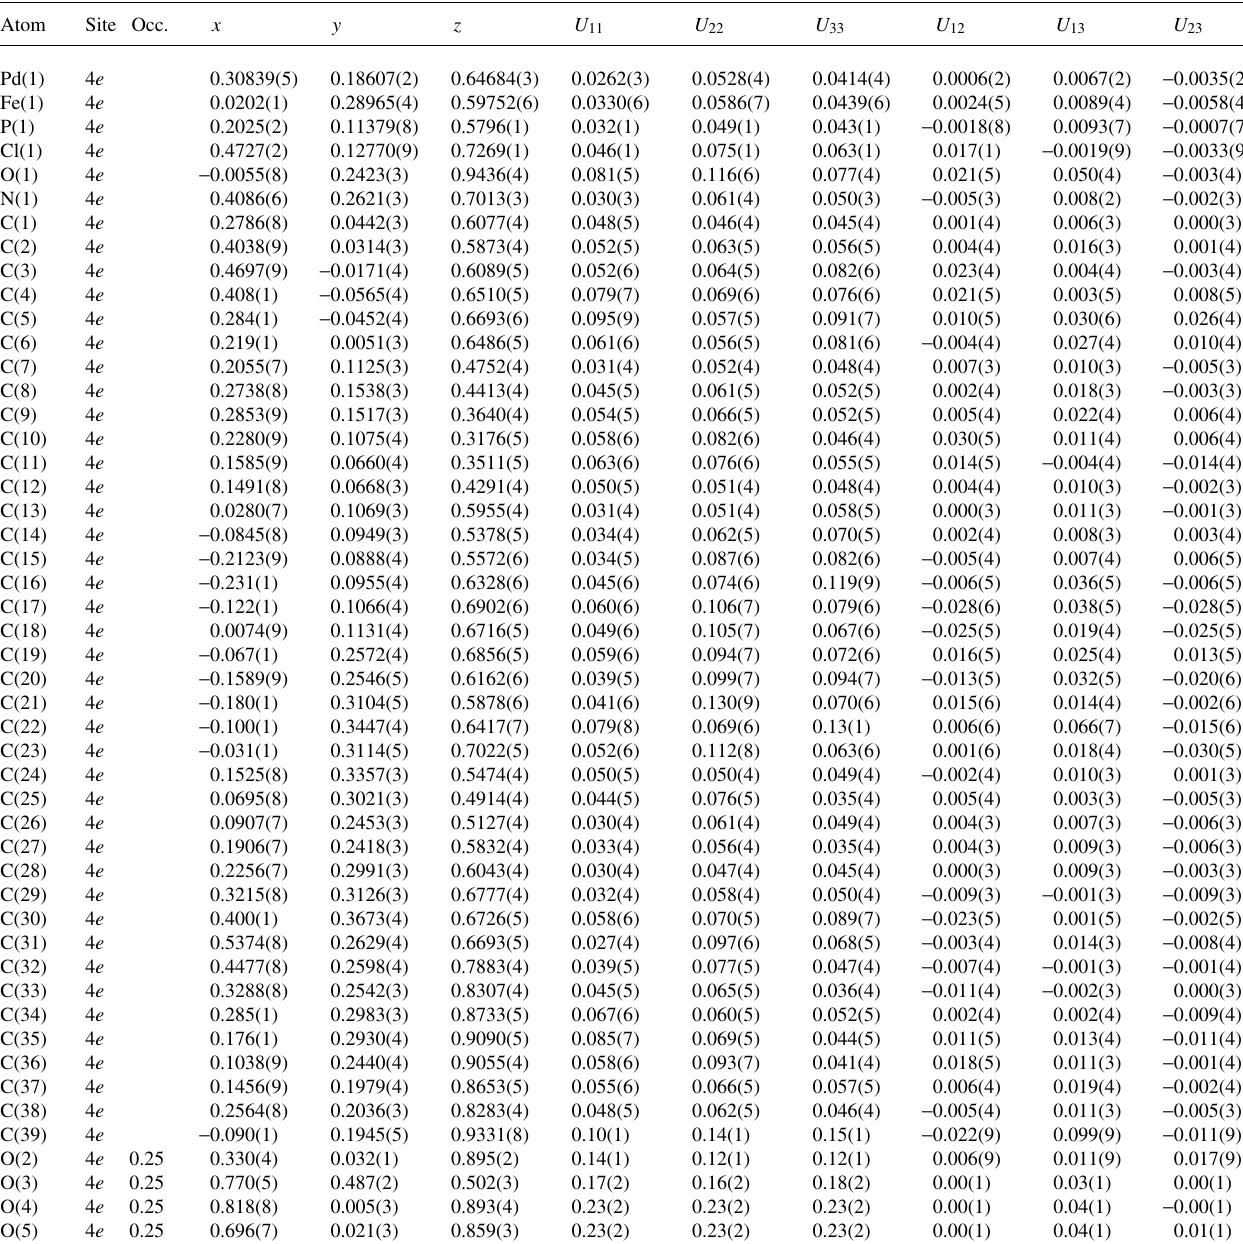
Table 3. Atomic coordinates and displacement parameters (in Å 2 )